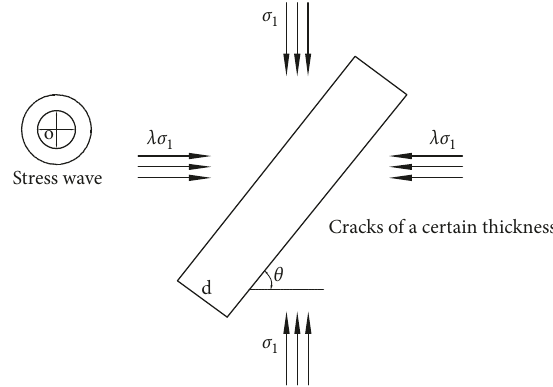
Figure 1: Stress conditions of cracks under stress waves and confining pressure.